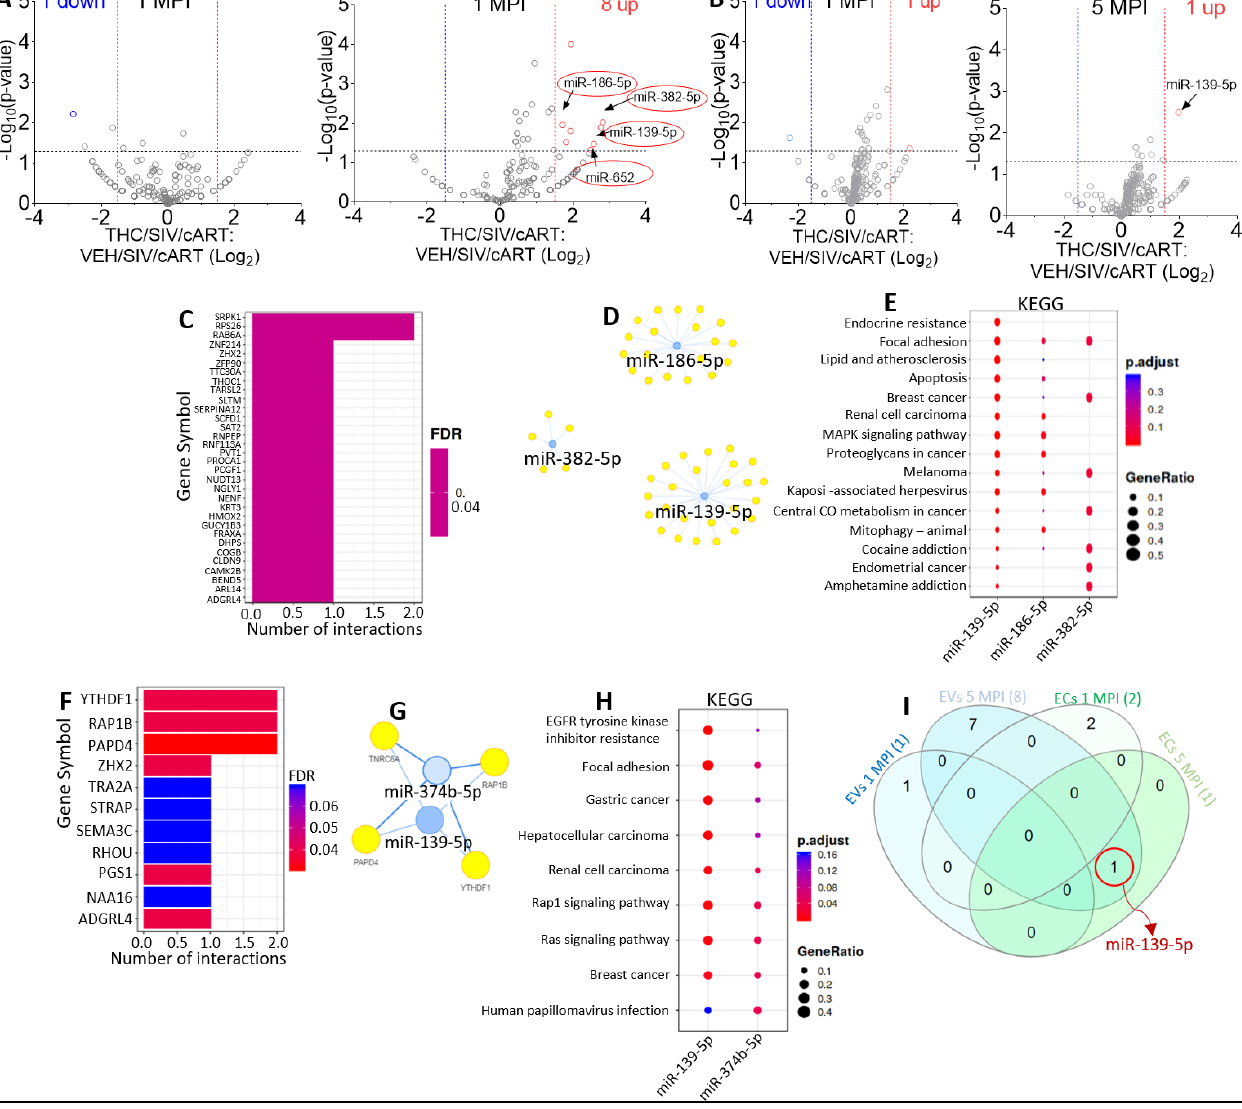
Figure 5. Alterations in miRNA profile of THC-treated SIV-infected cART-treated RMs. ( A ) Volcano plot showing down-(blue) regulated and up-(red) regulated miRNAs in THC/SIV/ART EVs relative to VEH/SIV/ART EVs at 1 MPI (left) and 5 MPI (right). Red circle indicates miRNAs (miR-186-5p, miR-382-5p, miR-139-5p, and miR-652) suppressed by ART treatment of SIV-infected macaques. ( B ) Volcano plot showing down-(blue) regulated and miRNAs in THC/SIV/ART ECs relative to VEH/SIV/ART ECs at 1 MPI (left) and 5 MPI (right). ( C ) miRNA-target enrichment analysis showing top target genes by number of interactions for miR-186-5p, miR-382-5p, miR-139-5p. ( D ) Visualiza- tion of miRNA-target interaction network for miR-574, miR-374b-5p and miRA-139-5p. The blue circles represent the miRNAs, while the target genes are represented by the yellow circles. Pathways are represented by blue lines. ( E ) Dot plot of functional enrichment analysis for target genes of miR- 186-5p, miR-382-5p, miR-139-5p. Color of dots represent adjusted p-values (FDR) and size of dots represents gene ratio (number of miRNA targets found enriched in each category/number of total genes associated to that category. ( F ) miRNA-target enrichment analysis showing top target genes